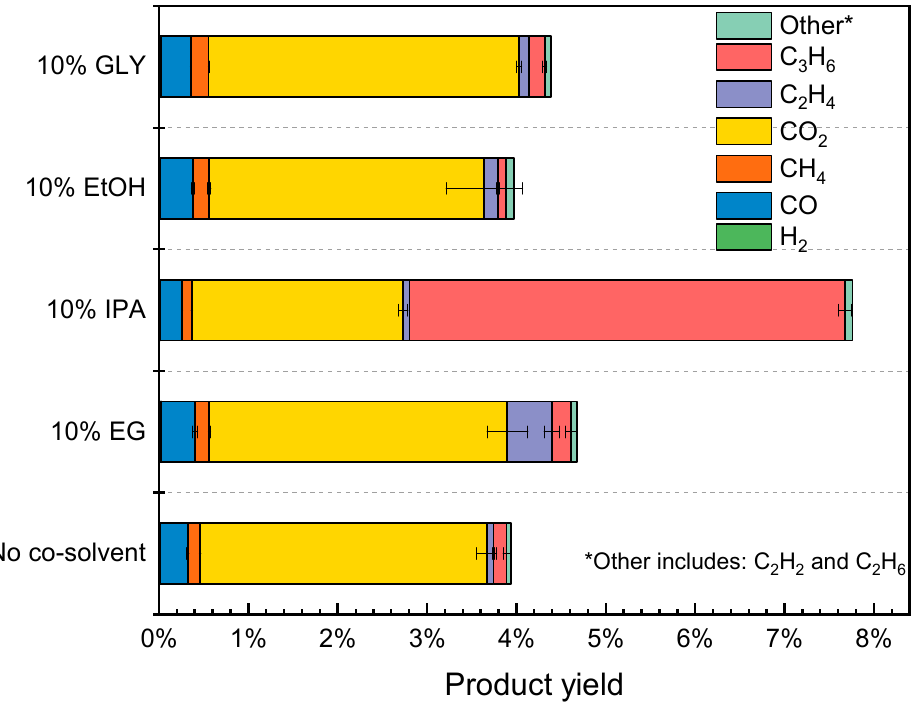
Figure 3. Gaseous product compositions and yields from HTL treatment of Tetraselmis sp. at 350 °C with different co-solvent inclusion (IPA: Isopropyl alcohol; EG: Ethylene glycol; EtOH: Ethanol; GLY: Glycerol). Error bars represent standard deviations from duplicate experiments.